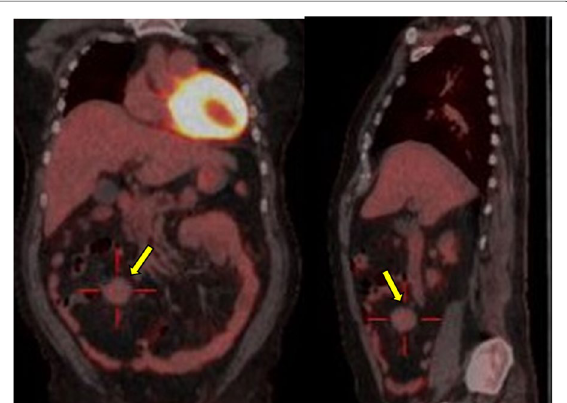
Fig. 2 Slight fluorodeoxyglucose uptake (maximum standardized uptake value, 2.0) in the right abdomen (arrows). A benign or low-grade malignant tumor was suspected